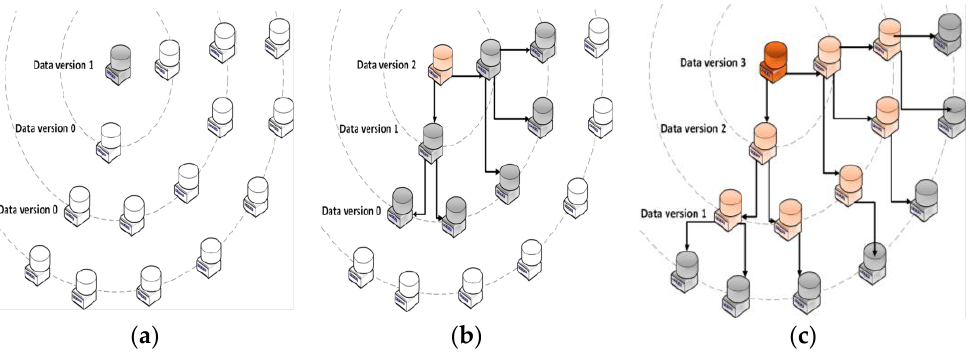
Figure 2. Epidemic replication protocol with three layers. Nodes from public or private clouds can be added to any layer at will. ( a ) Version 1 of data is generated at the core layer. ( b ) Version 1 is propagated to the next layer and a new version (i.e., version 2) is generated at core layer. ( c ) Data from Version 1 and 2 are propagated to their subsequent layers and a new version (i.e., version 3) is generated at the core layer.